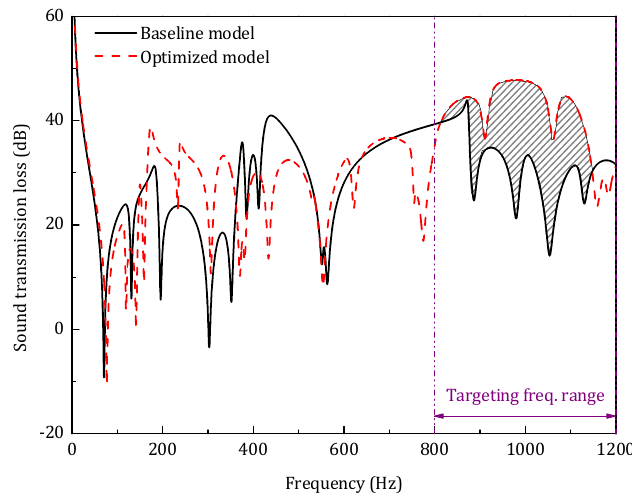
Figure 26. Sound transmission loss of the optimized model in the high-frequency range.